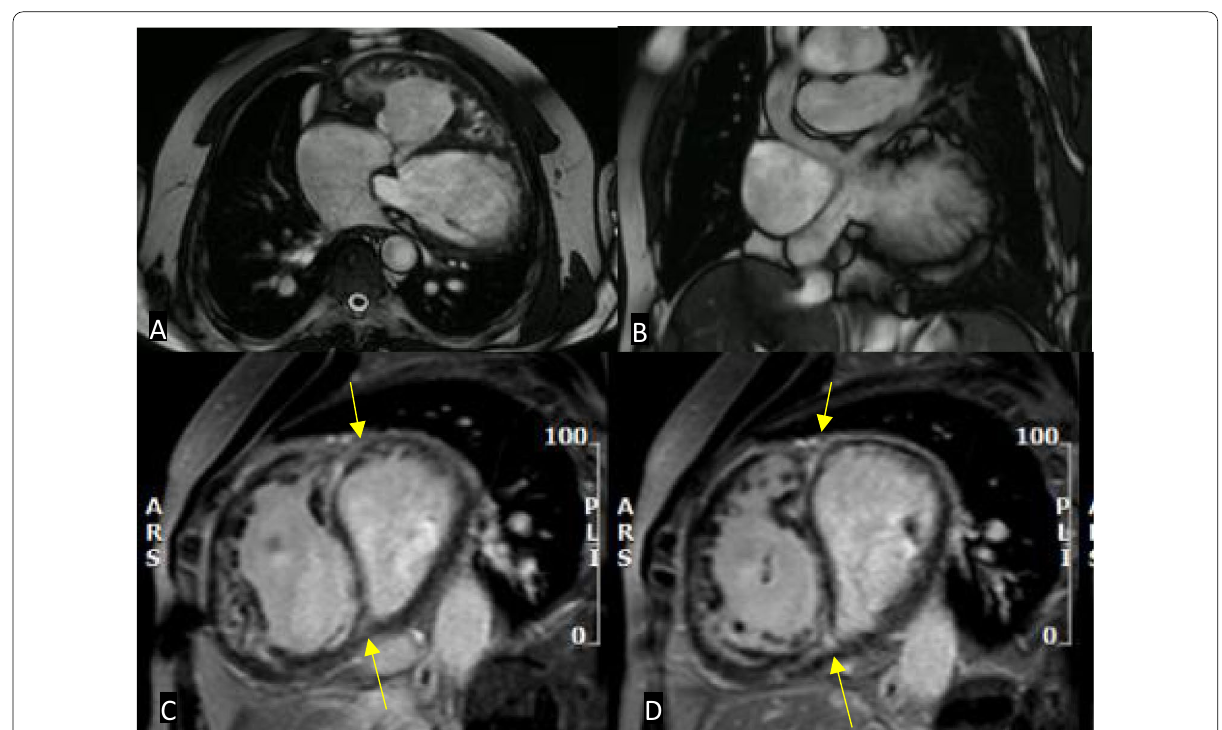
Fig. 11 Still shots of MRI SSFP cine in axial ( A ), coronal ( B ) planes and mid-ventricular short-axis views of inversion recovery sequence in the late gadolinium phase ( C , D ) demonstrating the appearances of the heart post-atrial switch procedure for D-TGA. A Normal appearances of the baffled pulmonary venous system to the right atrium and B venae cavae to the left atrium. C , D Right ventricular dilatation and hypertrophy with late gadolinium enhancement at the insertion points extending into the mid-septum (yellow